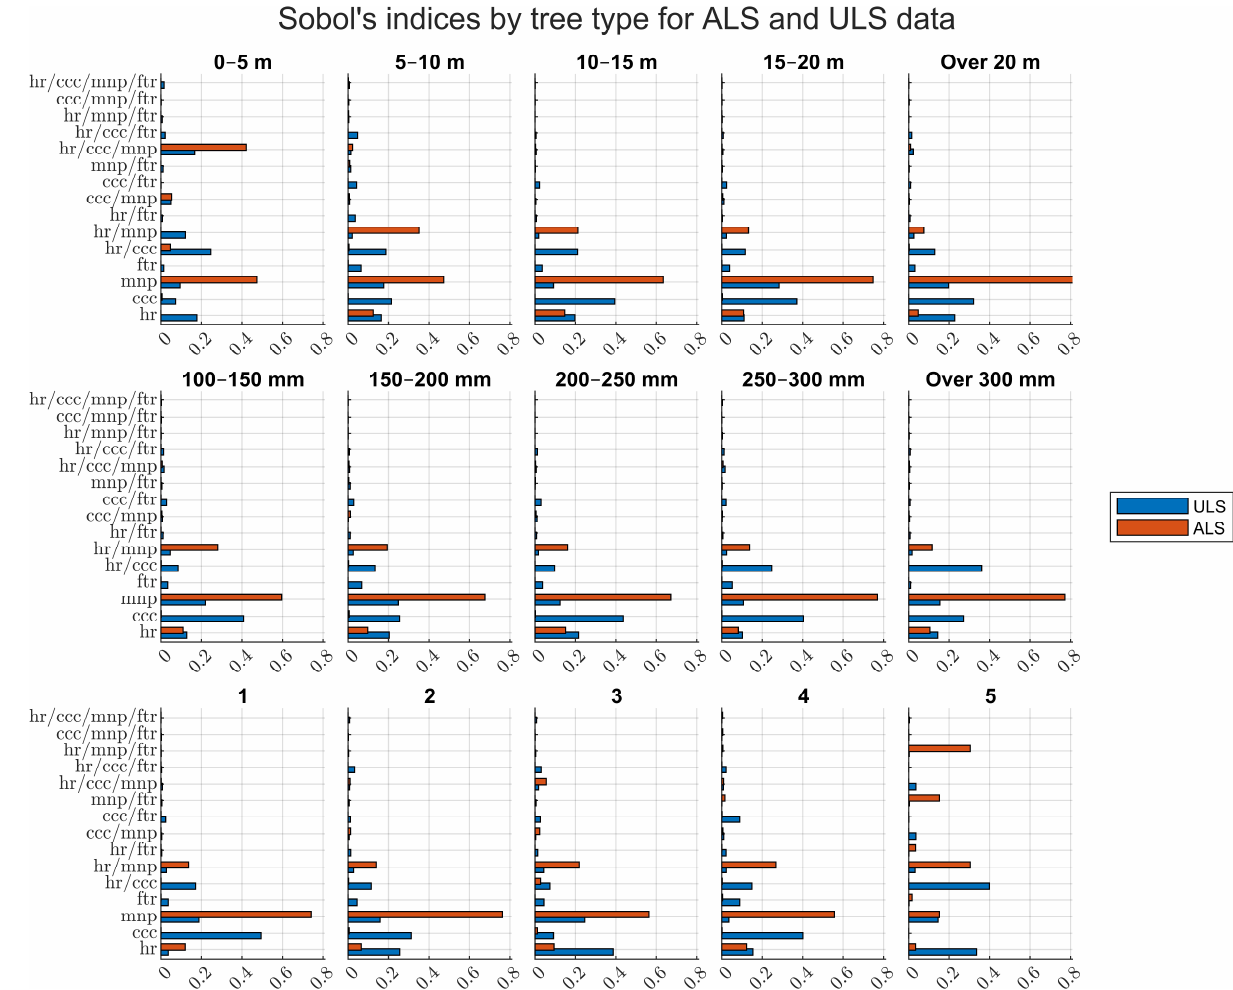
Figure 7. Sobol’s indices by reference tree type for ALS data and ULS data. MNP denotes the mini- mum number of points that must fall on the same line for a line to be detected, HR denotes the height range from which fallen trees are searched, CCC denotes the connected component classifier, and FTR denotes false tree removal. For example, the row labeled hr/ccc/mnp in the top-left plot represents the fraction of variance in recall of trees in length class 0–5 m explained by the interaction between the HR, CCC, and MNP parameters.